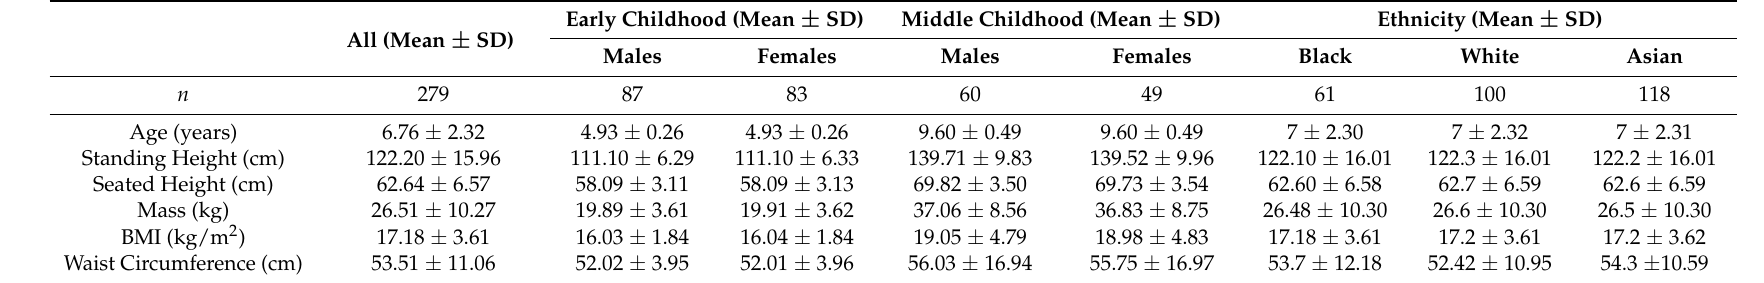
Table 1. Participant demographic variables by year group and